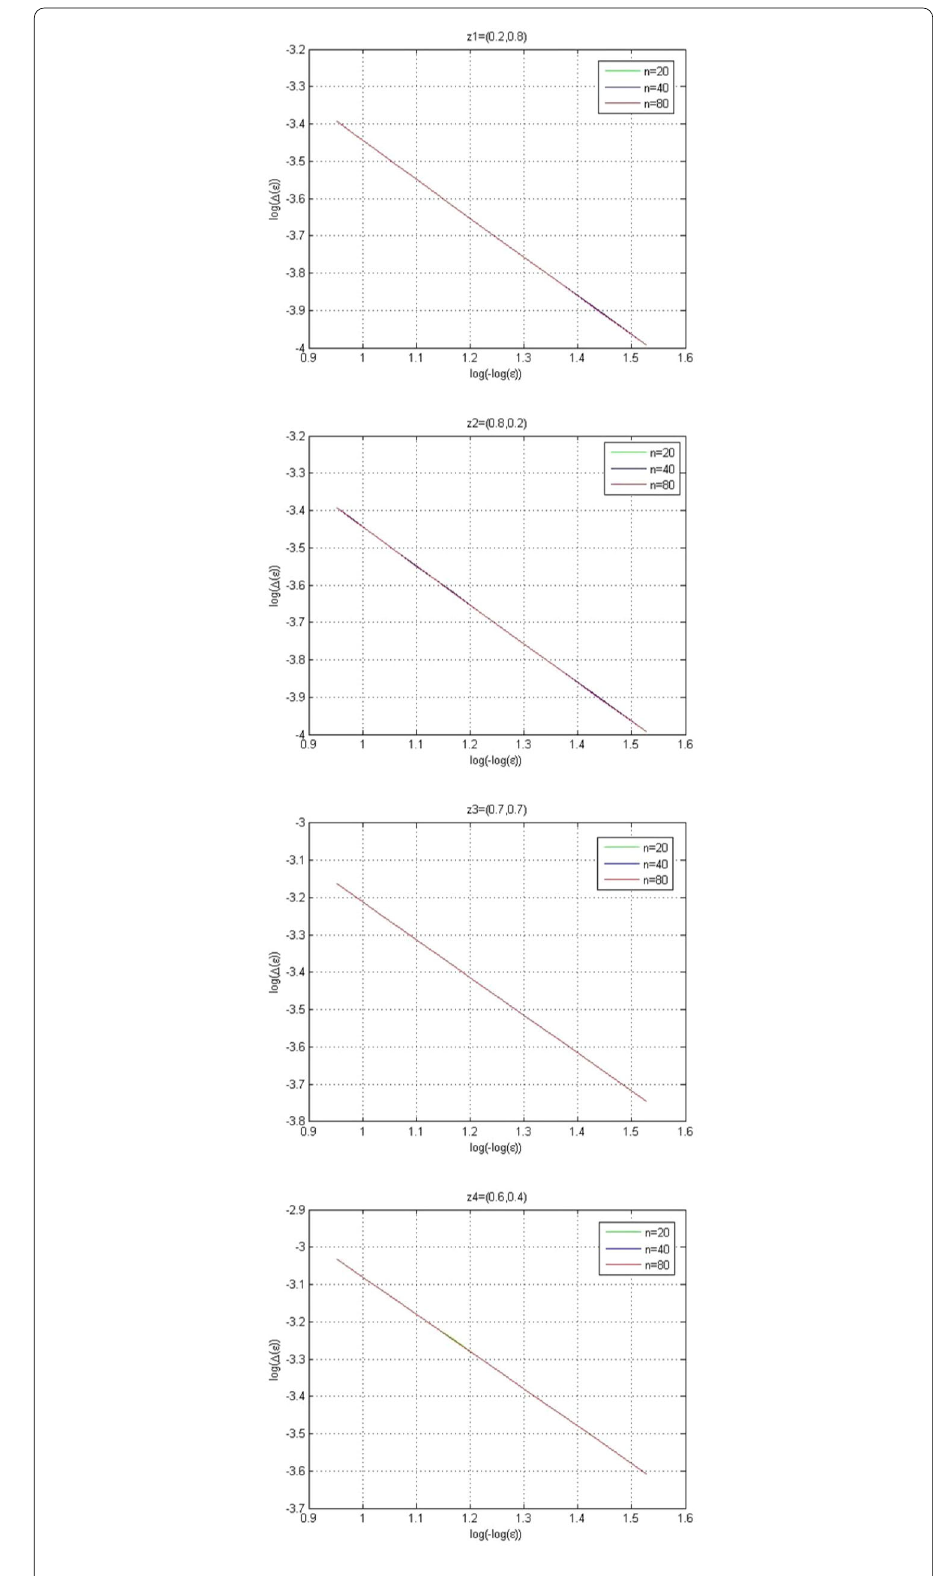
Figure 2 Variation of log( | (cid:6) z